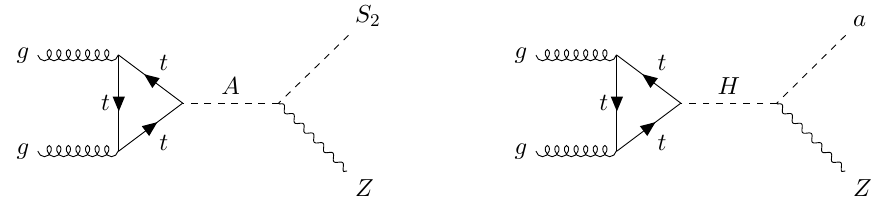
Figure 7 . Feynman diagrams for the resonant production of a mono- Z signal via gluon fusion production in the chosen mass hierarchy for the 2HDM+S (left) and 2HDM+PS